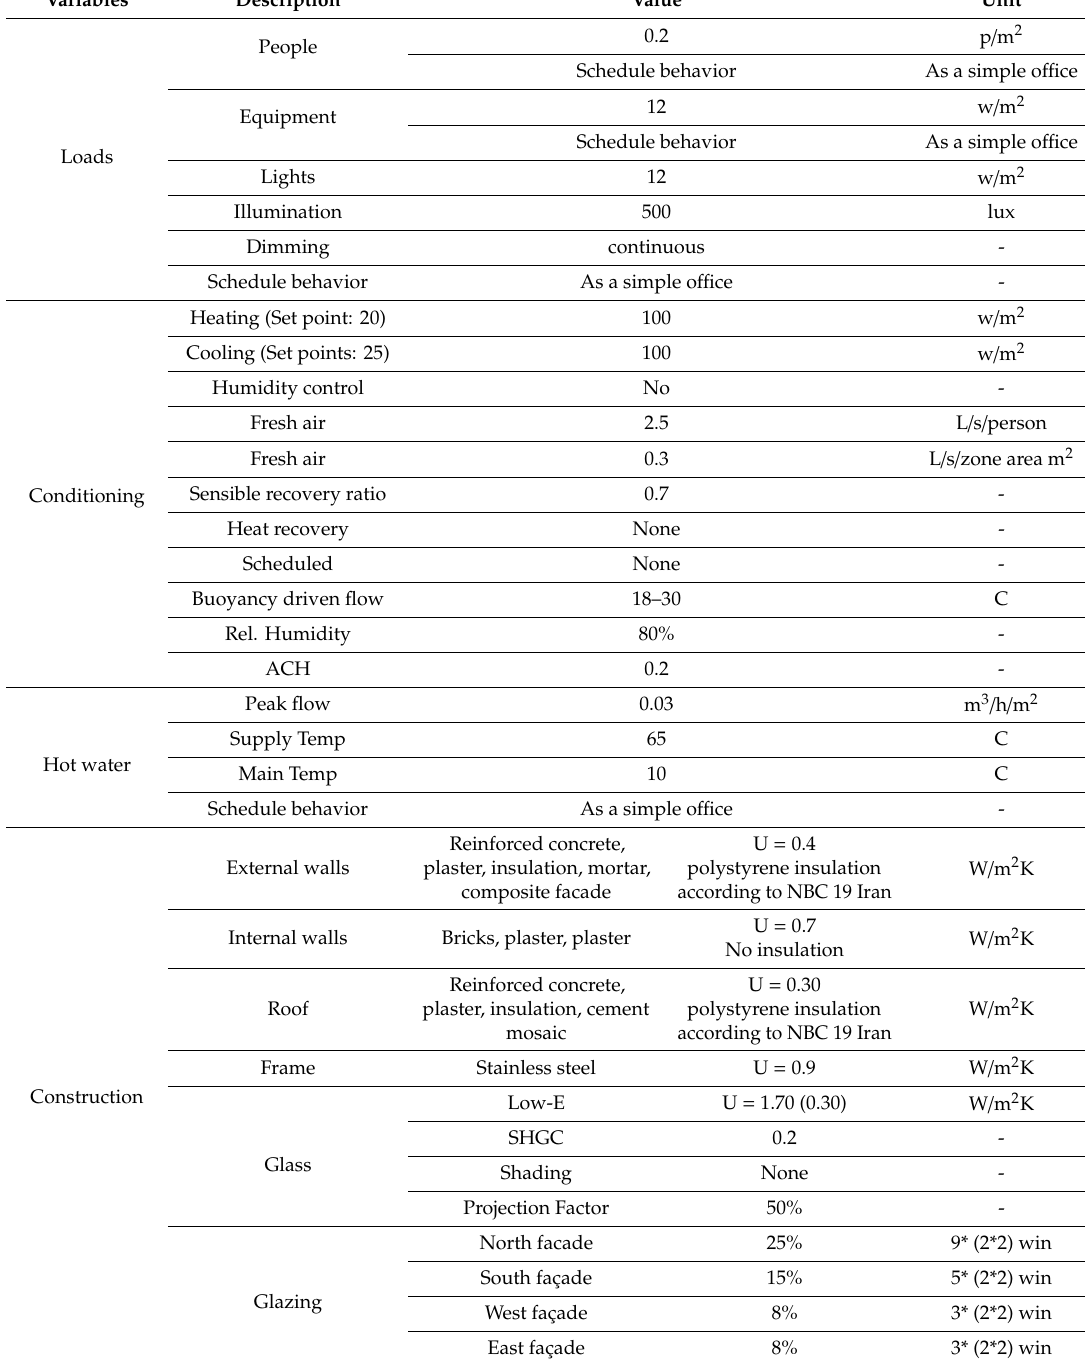
Table A1. The main variables applied in the energy performance